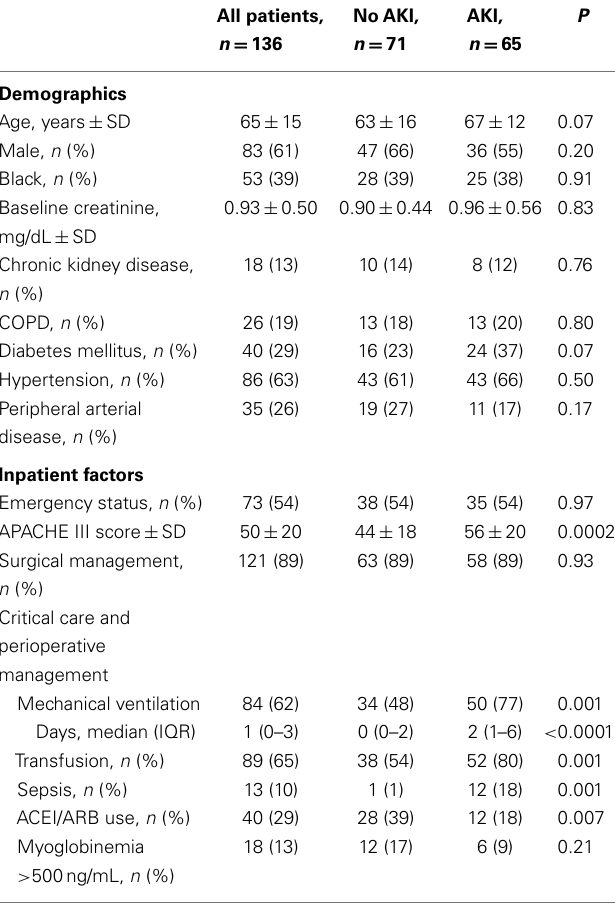
Table 1 | Characteristics of vascular surgery SICU patients